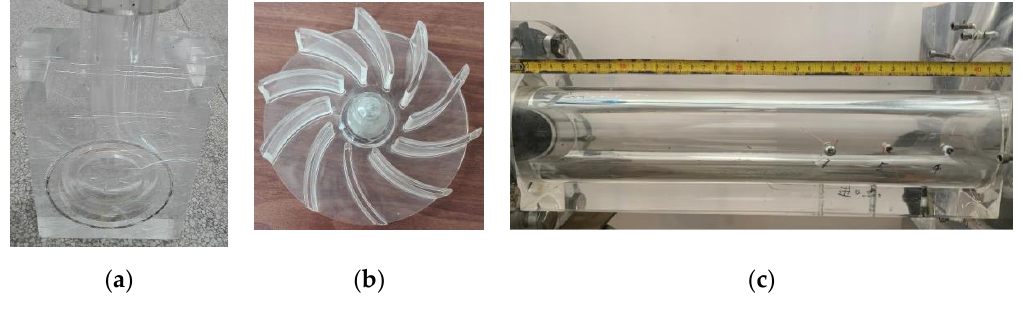
Figure 15. Testing pump: ( a ) Volute, ( b ) Impeller, ( c ) Pump inlet section.